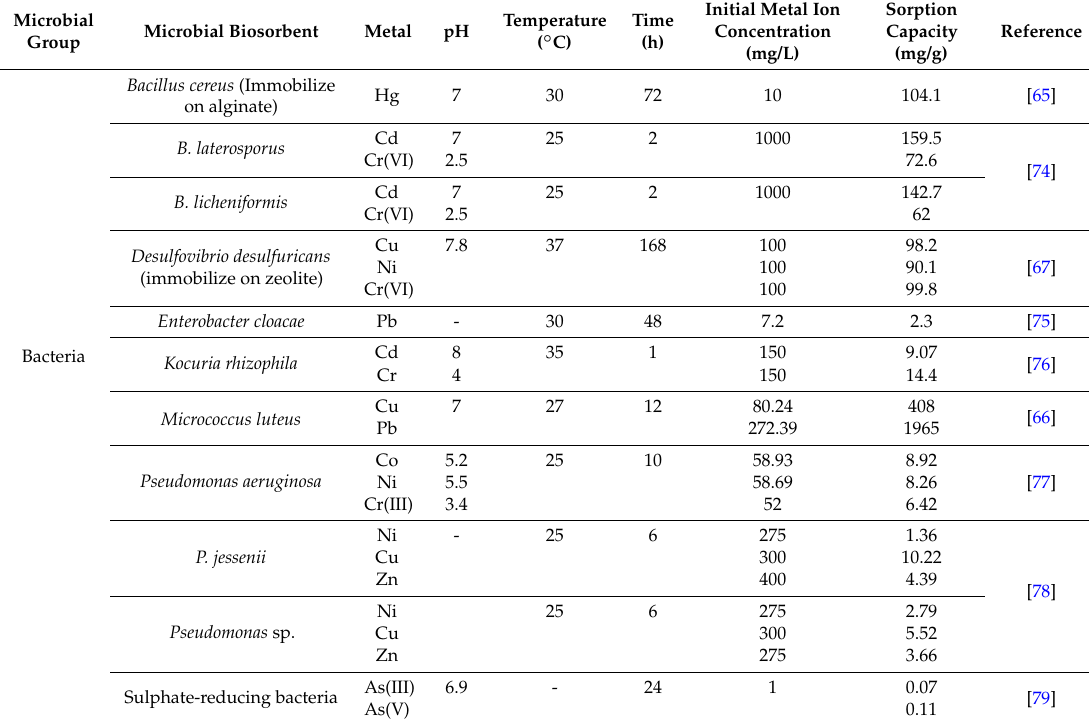
Table 2. Metal biosorption by different microbial